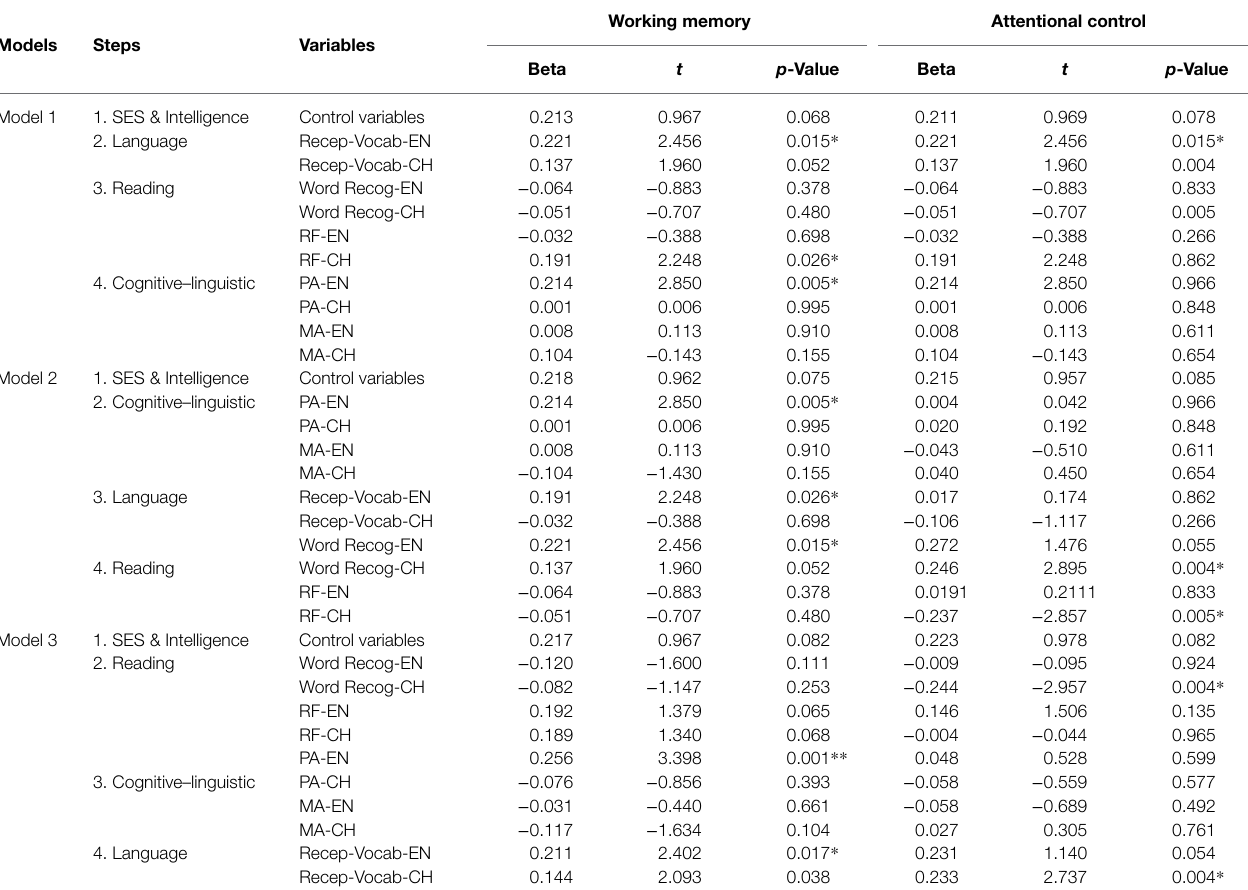
TABLE 7 | The contribution of SES, intelligence, reading and linguistic measures to cognitive skills at grade 3—hierarchical regression summary table.